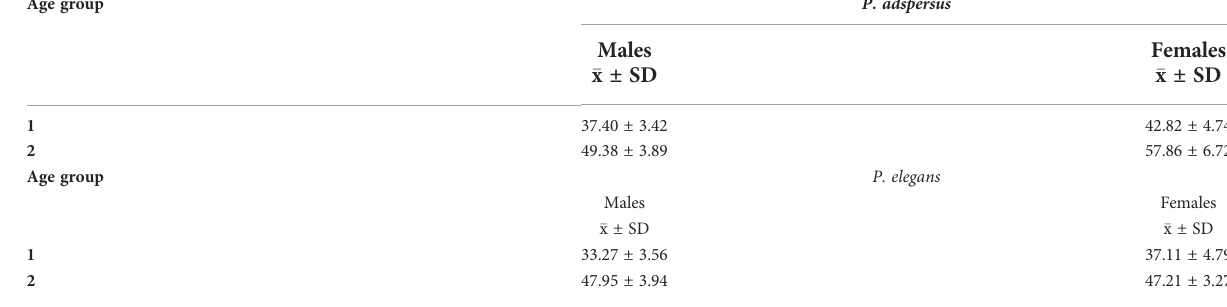
TABLE 1 Length at age (cohort) output from FiSAT II for (A) male and (B) female P. adspersus and P. elegans from the southeast Caspian Sea (2019 – 2020). Age